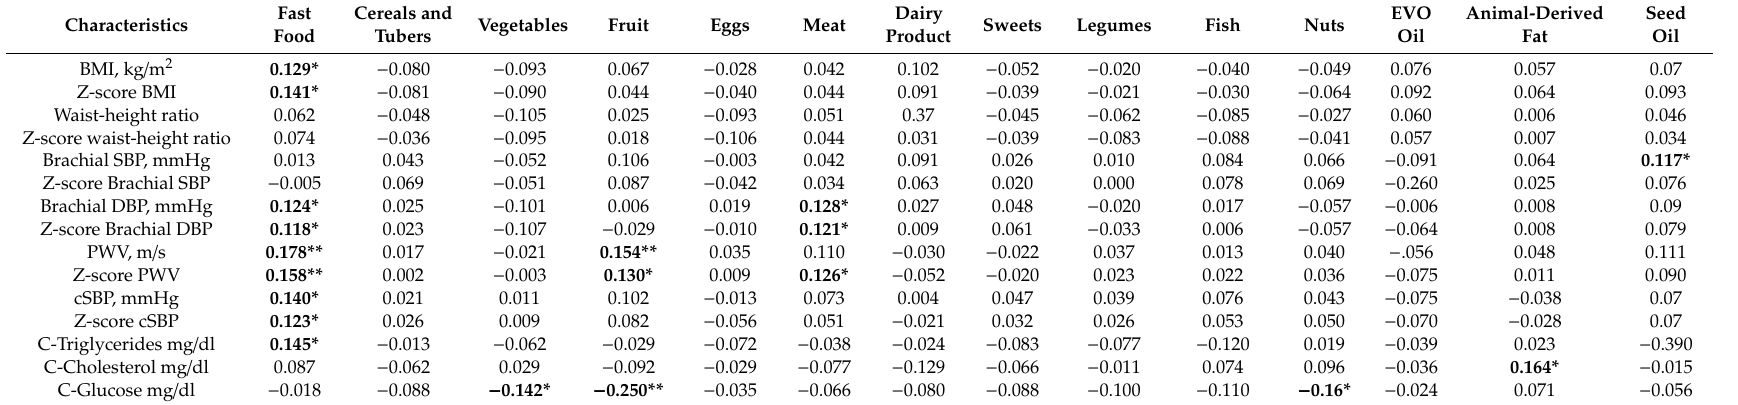
Table 2. Correlations between food intake and anthropometric, hemodynamic, and gluco-lipidic